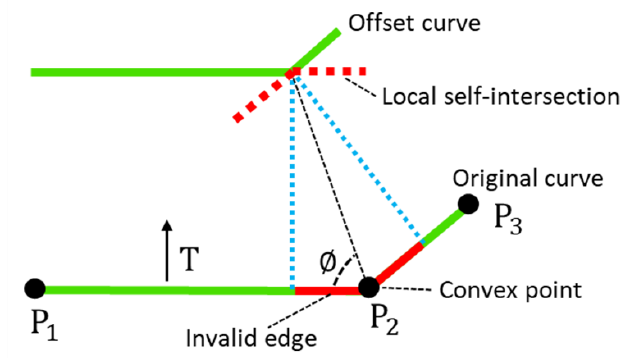
Figure 8. Convex point and local self-intersection.